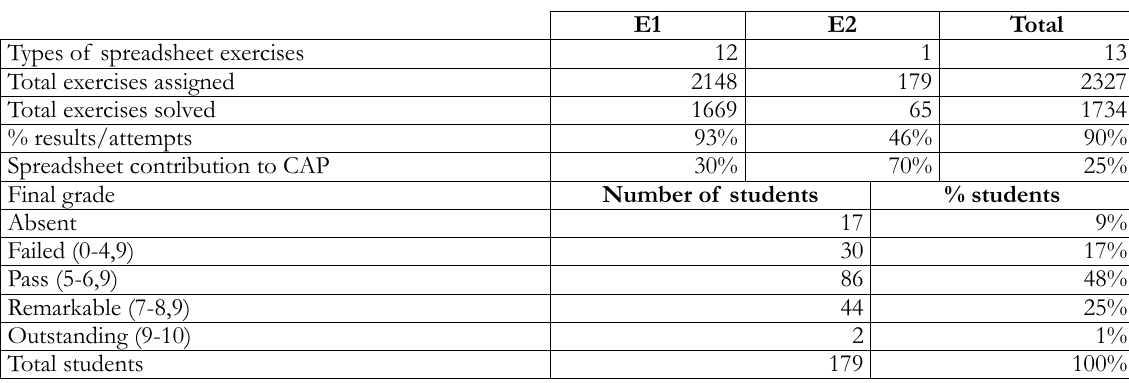
Table 3. The automatic spreadsheet corrector experience in figures- activities and